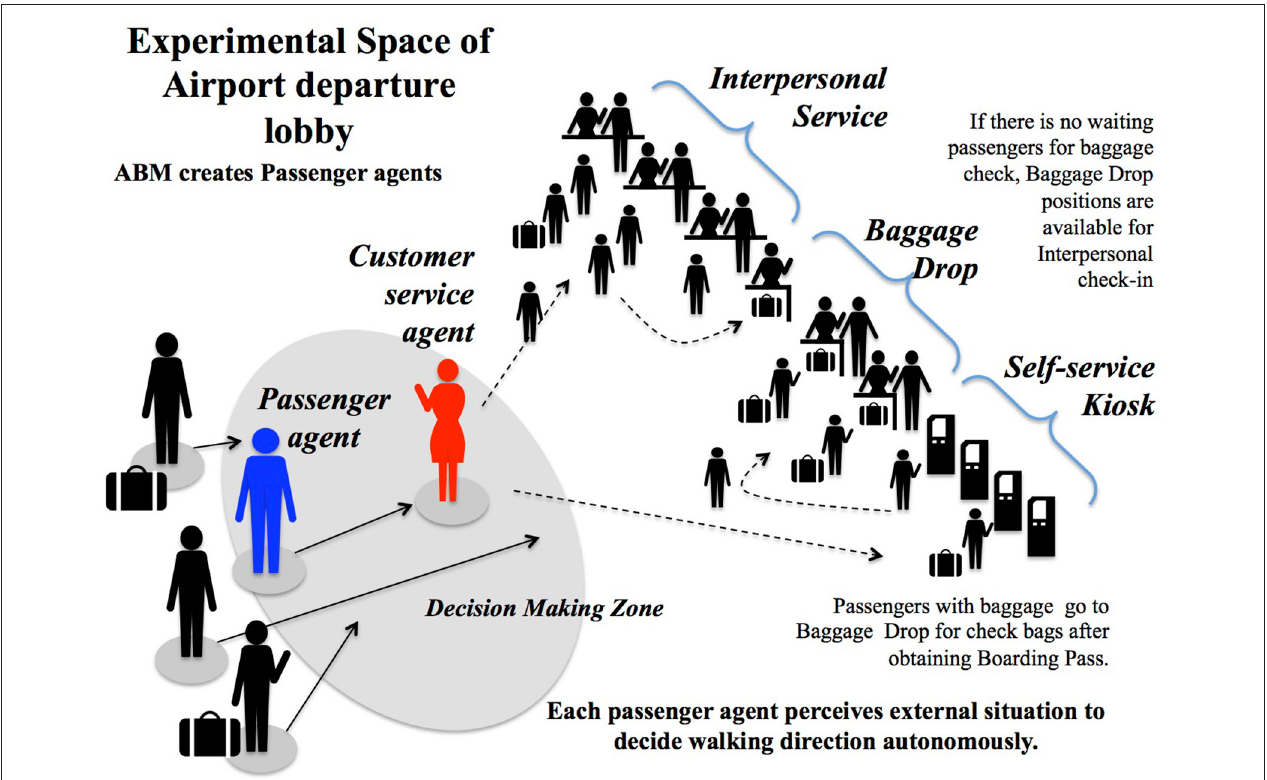
FIGURE 1 | SST adoption model.